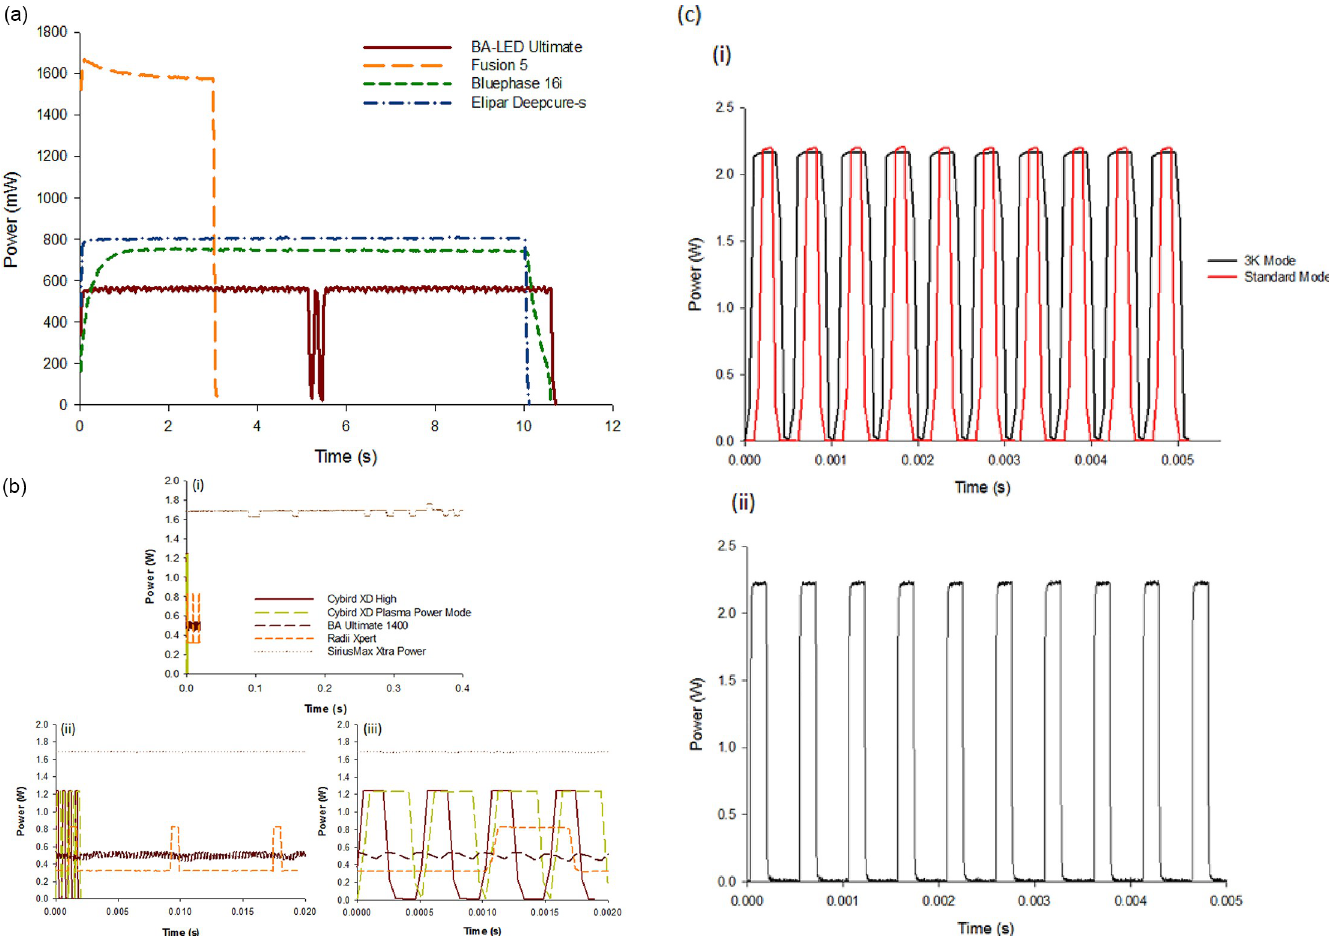
Fig 10. (a) Stable power output over time for the Elipar Deep Cure-S LED-LCU compared with other LCUs (BA Ultimate 1400, Bluephase 16i HIP mode, Fusion 5 Plasma power), recorded using the MARC LC spectrometer-based instrument acquiring data at 30 frames per second. A relatively slower rise in power output versus time is seen for the Bluephase 16i in "High Power" output mode while the output from the Fusion 5.0 declines slightly over the 3 s Plasma output mode run time. Note pulsing nature of light output for the BA Ultimate 1400 seen at the 30 Hz rate, (black) At ~5 s, the BA Ultimate 1400 LCU switches off briefly and immediately restarts. The pulsing output was found to relate to changes in the violet component of the light output over time. (b) Four of the eight LCUs from the 38 tested exhibiting pulsing output patterns in high speed (20 kHz) data acquisition mode with the PowerMax-Pro fast response power meter (S.P.E.C.3, Omega, I LED and Xlite 2 not shown). Fig 10Bi shows Power output (W) for the S.P.E.C.3 in standard and 3K modes. Ten pulses over 0.005s equalling a rate of 20 kHz for this LCU. Note similar peak power output in both modes with lower average power output for the standard mode due to longer off duty times between pulses. The manufacturers claimed irradiance values for these modes (1600 and 3000–3500 mW/cm 2 ) corresponded closely with GS irradiance data recorded using the I.S./spectrometer test method (~1900 and ~3400 mW/ cm 2 ). Fig 10ii to iv show the outputs for the BA Ultimate 1400, Radii Xpert, in their standard operating modes. The Cybird XD LCU in High and Plasma power output modes and the Sirius Max in Xtra power mode. The standard output mode for the Sirius Max showed steady output with no pulsing behaviour. Fig 10ii to 10iii are the same apart from the different x-axis time scales. (c) (i) shows power output for the S.P.E.C.3 in standard and 3k modes. Ten pulses over 0.005s equalling a rate of 20 kHz for this LCU. Note similar peak power output in both modes with lower average power output for the standard mode due to longer off ‘duty’ times between pulses. Depending on tip diameter (8 or 11 mm), averaged power values recorded with GS method were ~1.45–1.55 W for 3K mode and 0.85–0.9 W for standard mode and ~0.1 W less as recorded with the LabMax-Pro as displayed here. The manufacturers claimed irradiance values for these modes (1600 and 3000–3500 mW/cm 2 ) corresponded closely with GS irradiance data recorded using the I.S./spectrometer test method (~1900 and ~3400 mW/cm 2 ). (ii) shows the standard output mode for the S.P.E.C.3 recorded this time with the LabMax-Pro operating in Snapshot mode at 625 kHz. Note changes in pulse shape between (i) and (ii) due to ~30-fold increase in acquisition